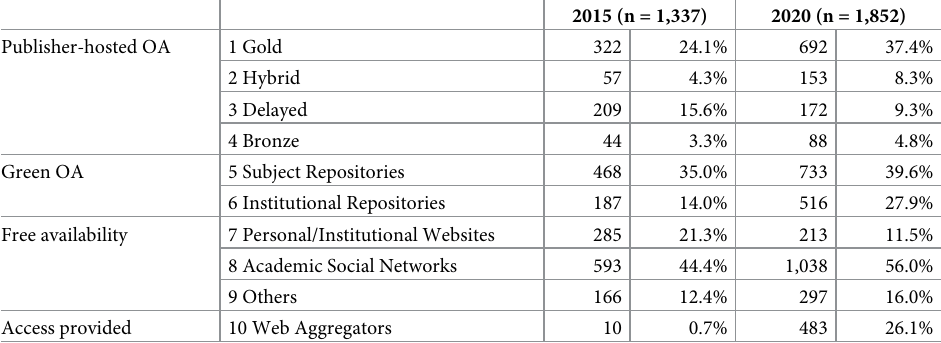
Table 3. Proportion of modes of open access (OA)